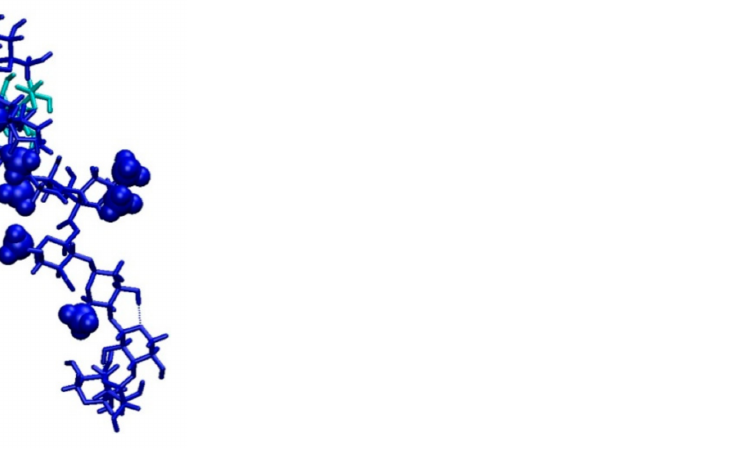
Figure 6. GOTCAB saponin dimer with monomers shown in blue and cyan, respectively. The aglycone CH 3 groups are represented by balls dimensioned in proportion to the van der Waals radii. The dashed line represents an intramolecular